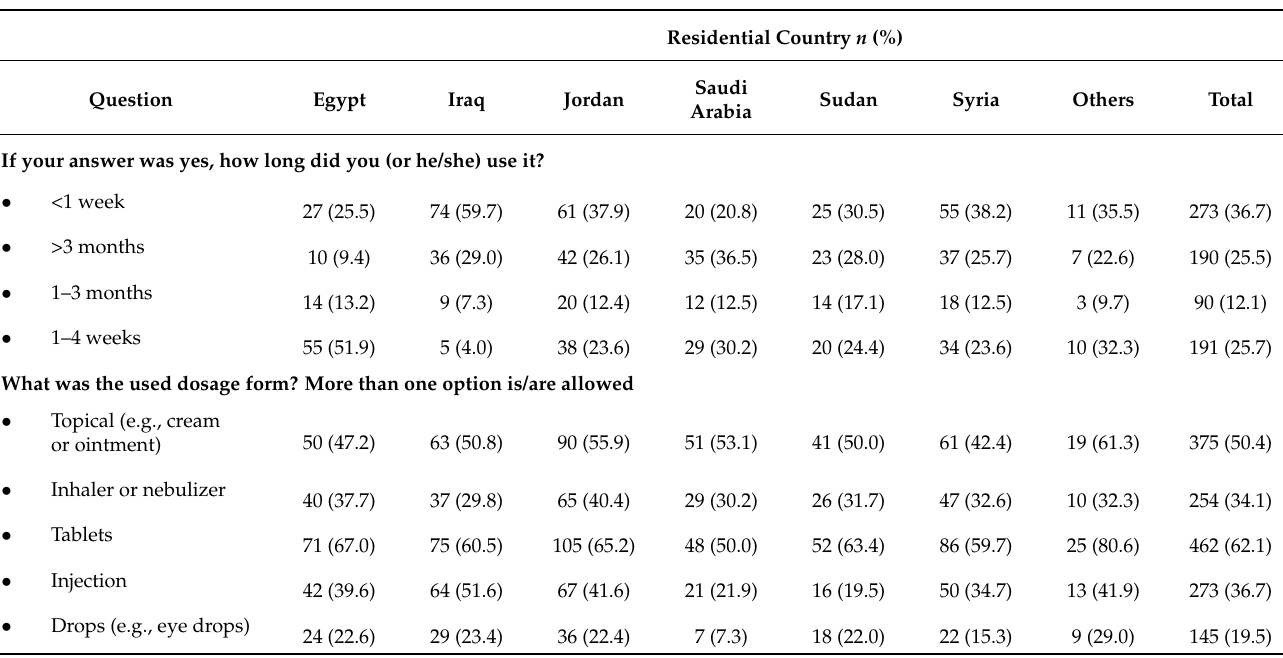
Table 3. Participants’ reported experience with corticosteroid usage in different countries (total n =